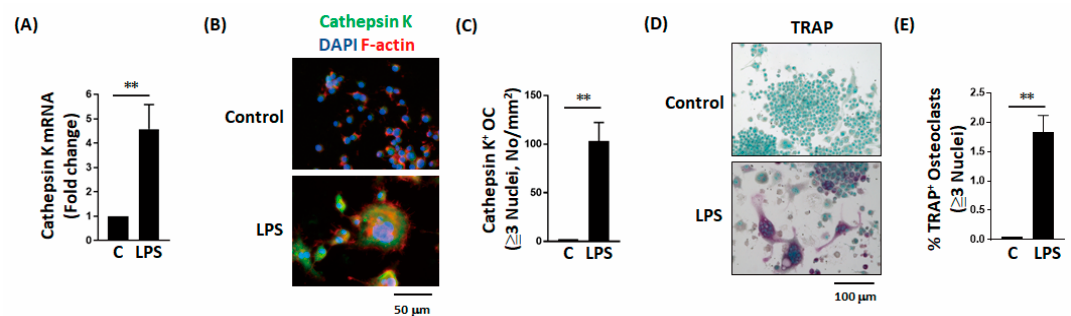
Figure 3. LPS enhances osteoclastic cell differentiation in vitro. ( A – C ) LPS not only increases cathepsin K expression but also increases the number of cathepsin K-positive cells during osteoclast differentiation. ( D , E ) LPS increases both the expression intensity of TRAP and the percentage of TRAP-positive cells during osteoclast differentiation. Data are presented as the mean ± standard error of the mean. Analyses were conducted with two-way analysis of variance followed by Bonferroni’s post-hoc test. ** p < 0.01. Abbreviations: TRAP, tartrate-resistant acid phosphatase; LPS, lipopolysaccharides; OC, osteoclasts; C, vehicle control.